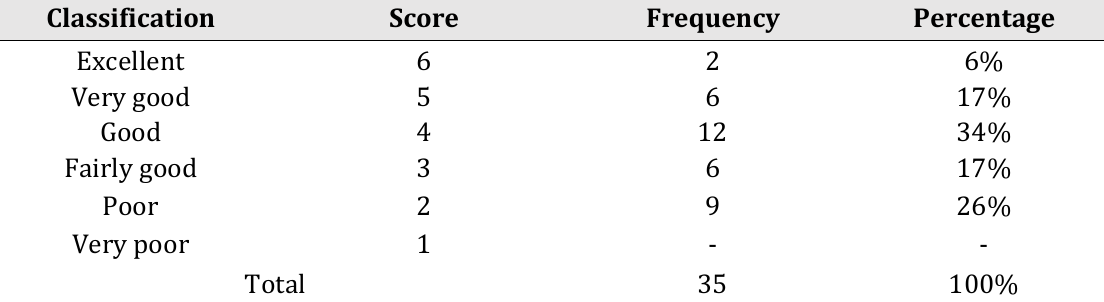
Table 17. Rate percentage point of learners’ comprehensibility